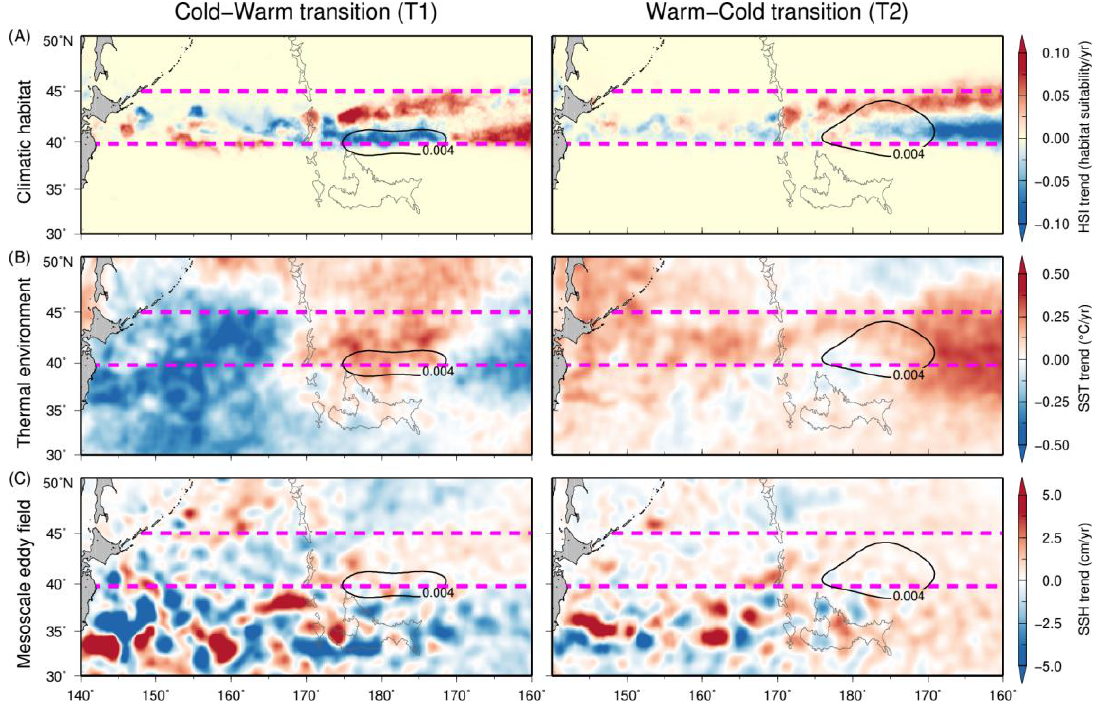
Figure 6. Spatial maps of the temporal trends computed for ( A ) potential squid habitat, ( B ) thermal environment, and ( C ) mesoscale eddy field, during the PDO phase transitions from a cold to warm (T1, left panels) and warm to cold (T2, right panels) phase. The spatial signals of the decrease and increase in the climatic habitat suitability, temperature and mesoscale activity for a given phase transition are represented by blue and red shades, respectively. The solid contours correspond to the highest spatial density of squid fishing effort for each climatic transition, gray polygons represent the topographic features and the region within the broken lines correspond to the spatial domain of the subarctic frontal zone (SAFZ).